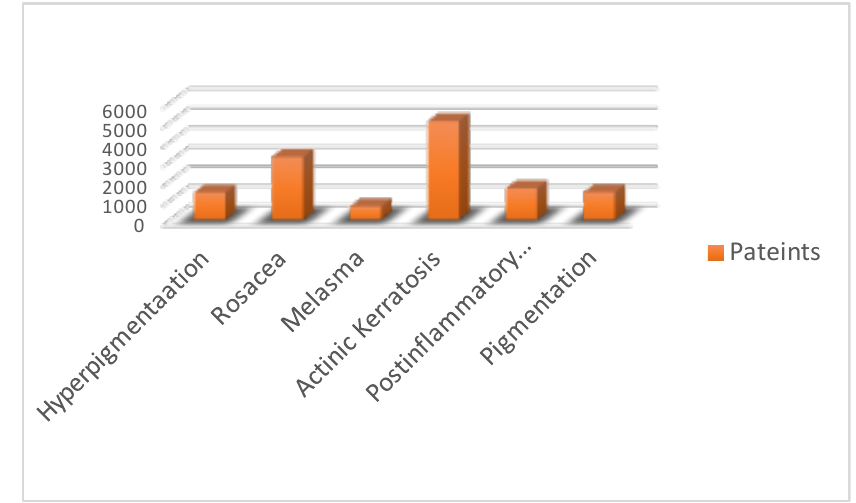
Figure 1. Distribution of patients at UCSF for each skin condition in our study.